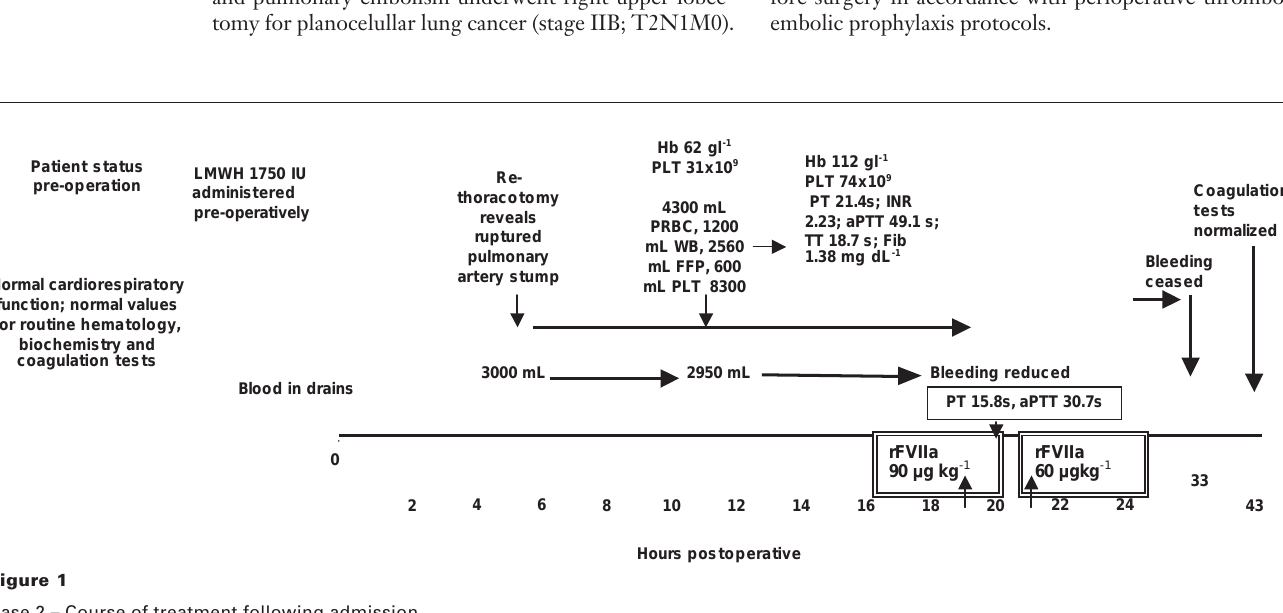
Fib, Fibrinogen; Hb, Haemoglobin; Htc, haematocrit; INR, international normalised ratio; LMWH, low-molecular weight heparin; PLT, platelet concen- trates; PRBC, packed red blood cells; PT, prothrombin time; rFVIIa, recombinant factor VIIa; Time 0 = end of surgery; TT, thrombin time; vit K, vitamin K;